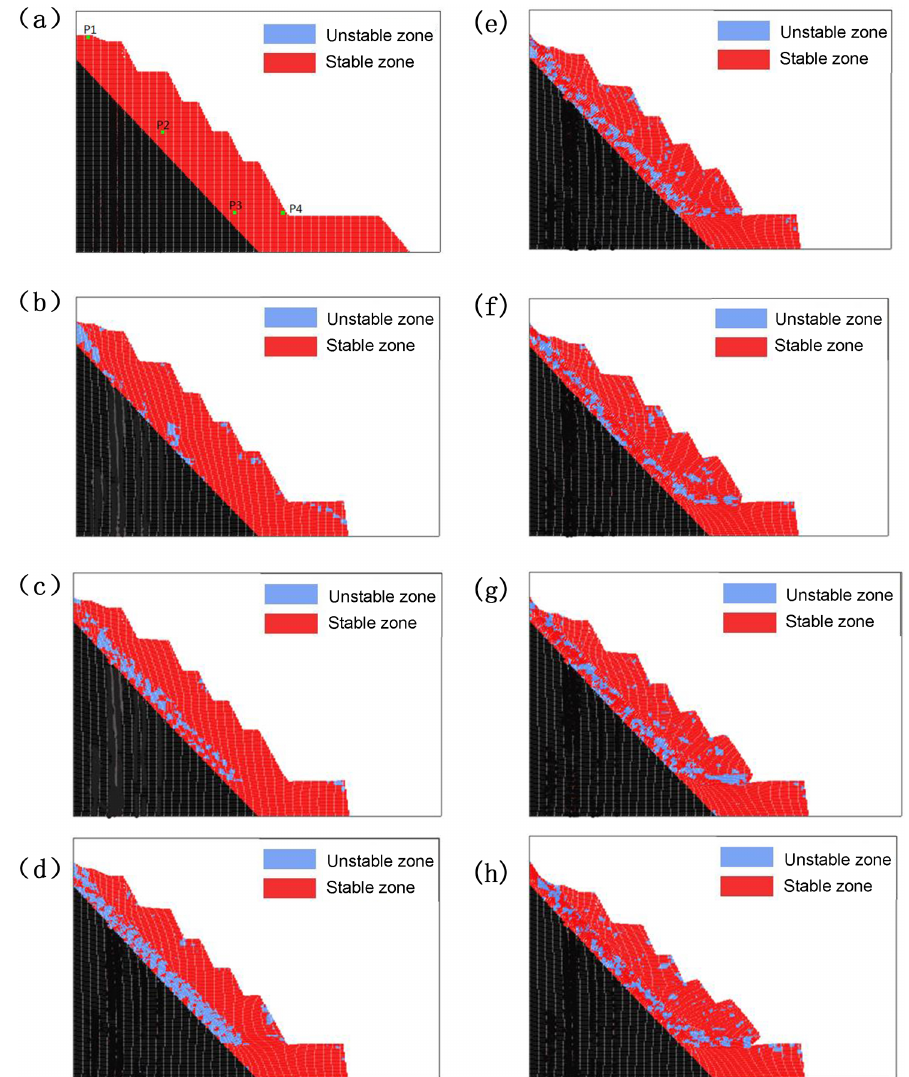
Figure 13. Stable zones (red) and the development of unstable zones (blue) during the consistent evolution of the rockslide. (a) Initial configuration after gravity initialization. (b) Unstable zones after excavation. (c) Water infiltration after 12h. (d) Water infiltration after 25h: D 2 W norm = 0. (e) Slip configuration after 1s. (f) Slip configuration after 3s. (g) Slip configuration after 5s. (h) Slip configuration after